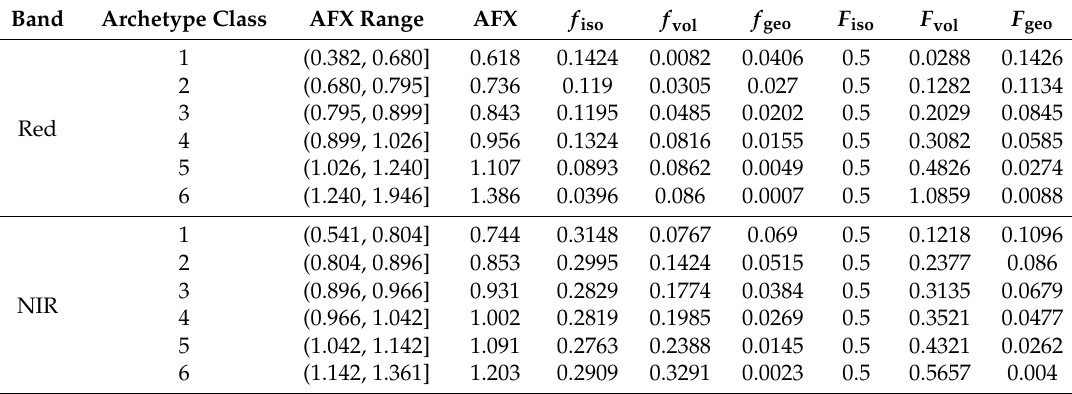
Table 1. The AFX and six BRDF archetypal parameters in the original ( f * ) and normalized ( F * ) forms for the red and NIR